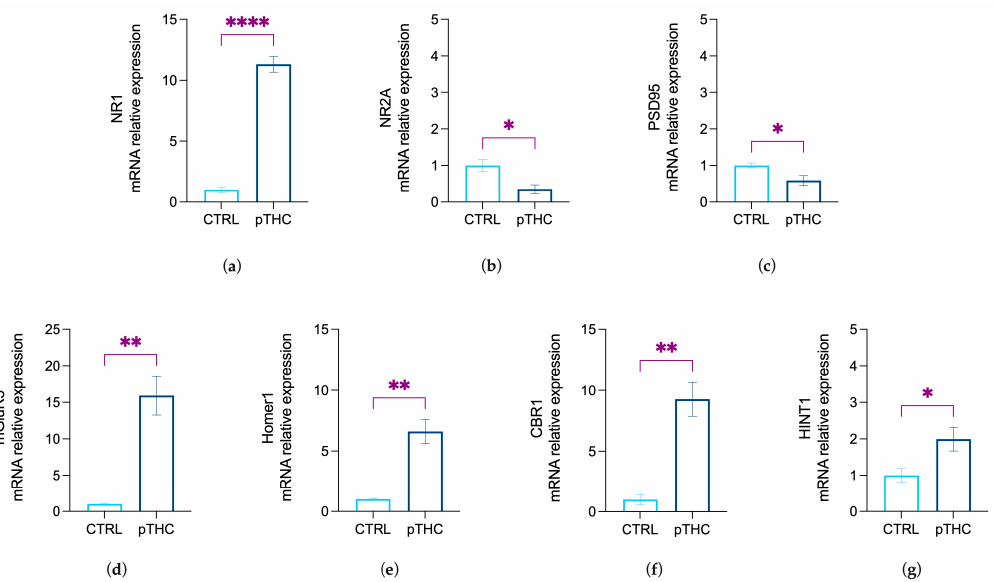
Figure 8. Prenatal THC exposure (2 mg/kg) alters the mRNA relative expression levels of the effectors of excitatory and ECS-driven downstream signalling in adolescent rats. Prenatal THC exposure ( a ) increased the expression levels of the NMDAR NR1 subunit and decreased ( b ) the levels of NR2A and ( c ) PSD95 in the hippocampus of the adolescent male rat offspring. ( d ) pTHC induced an increase in mGluR5, as well as ( e ) its scaffolding partner Homer1 isoform in the hippocampus of the adolescent progeny. Lastly, ( f ) CB1R and ( g ) HINT1 were increased by